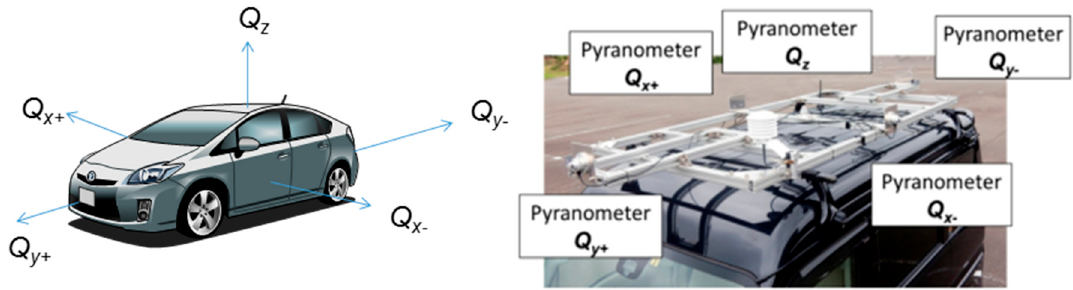
Figure 12. Measurement system on the car using five pyranometers on the orthogonal axis.